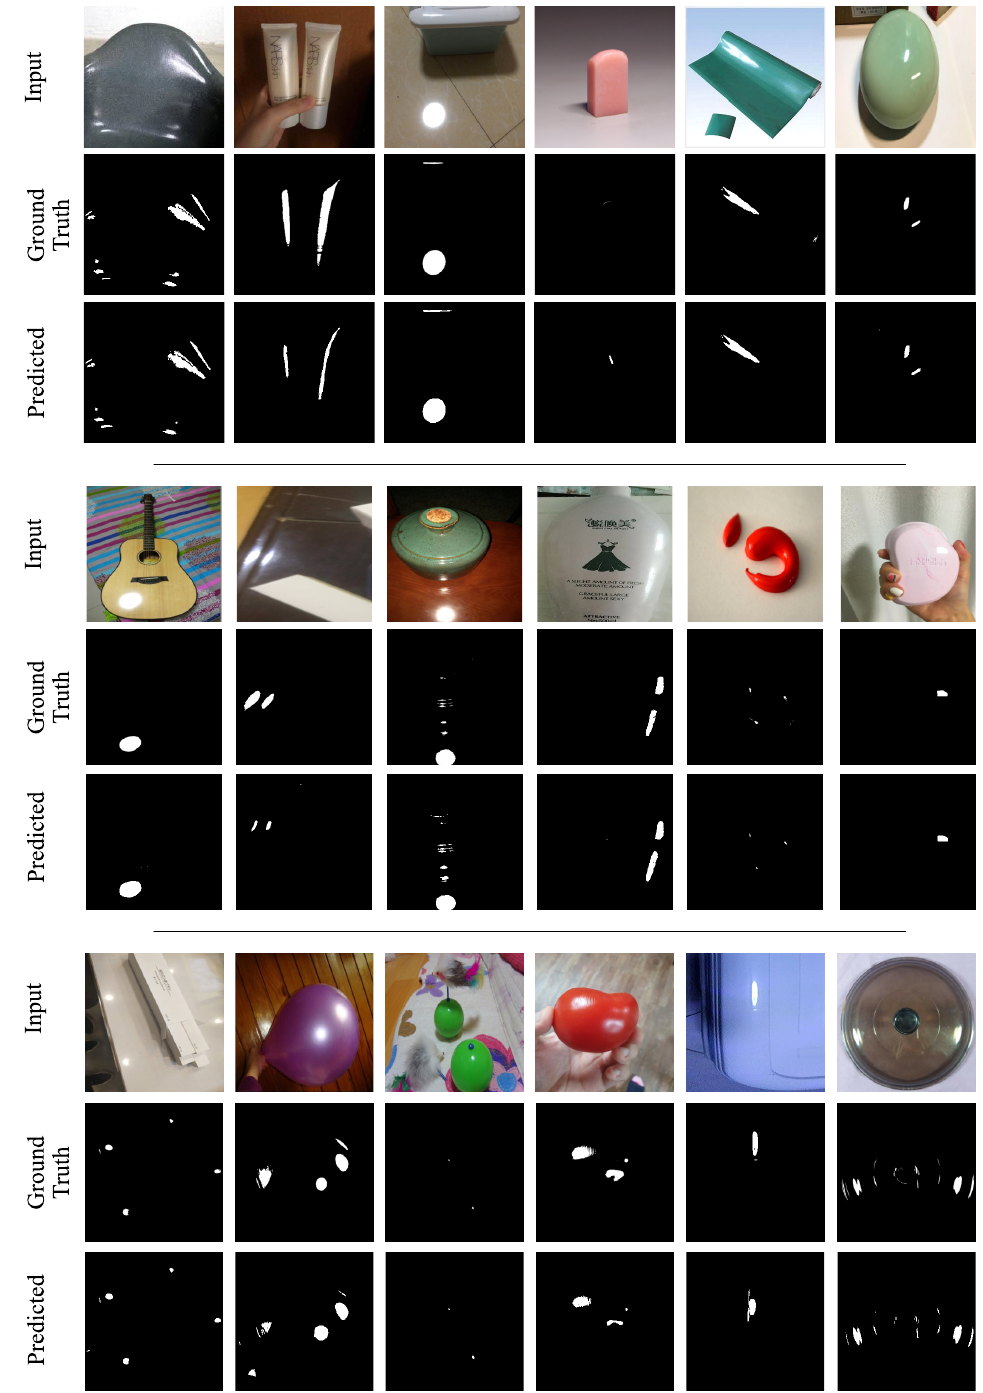
Figure A1. Segmentation results of SpecSeg network as compared to manually labelled ground truths in the Whu-Specular dataset